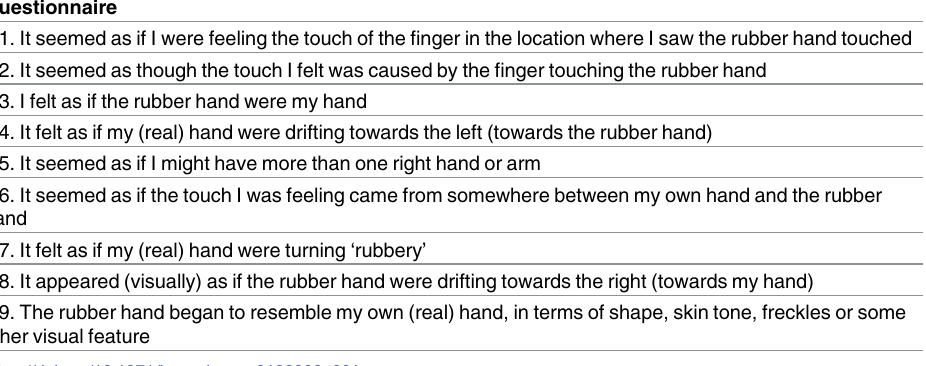
Table 1. Questionnaire on subjective experienceof the rubber hand illusion assessed after each trial.